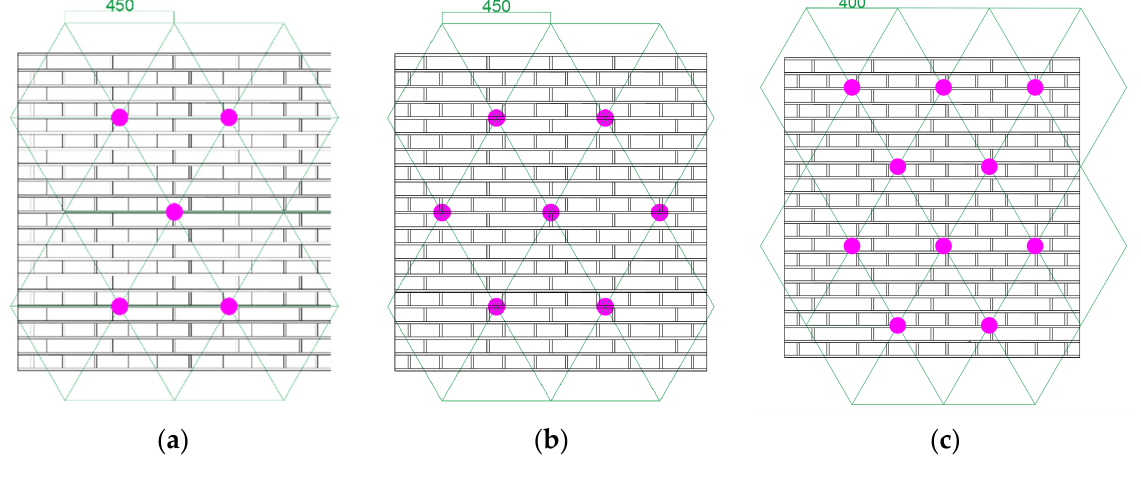
Figure 20. Anchors patterns: ( a ) N5; ( b ) N7; ( c ) N10.